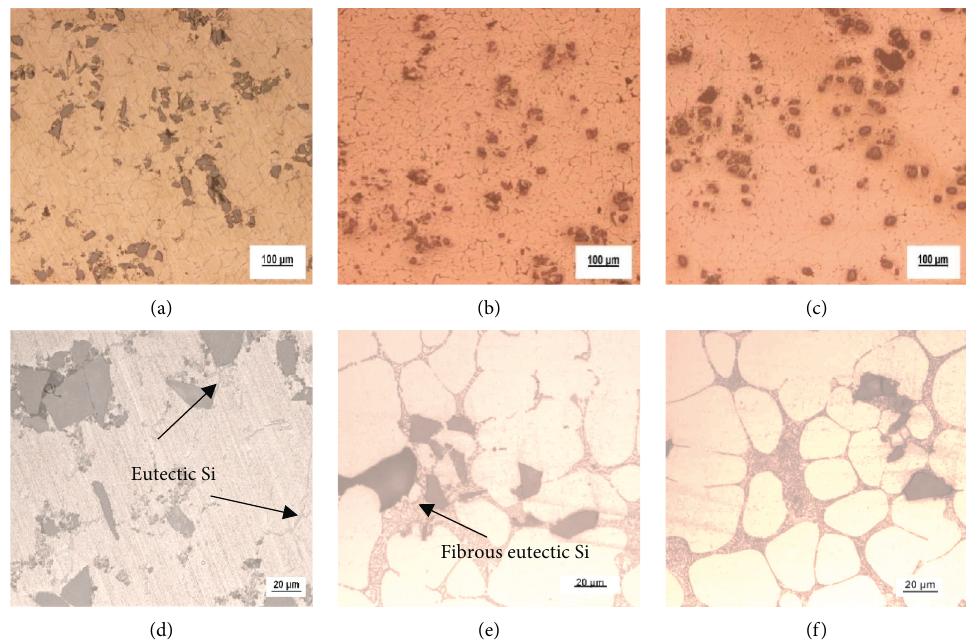
Figure 9: The effects of addition temperature on the microstructure and SiC 720 °